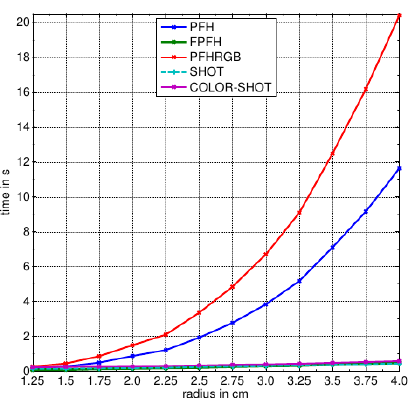
Figure 12: Runtime of point descriptors